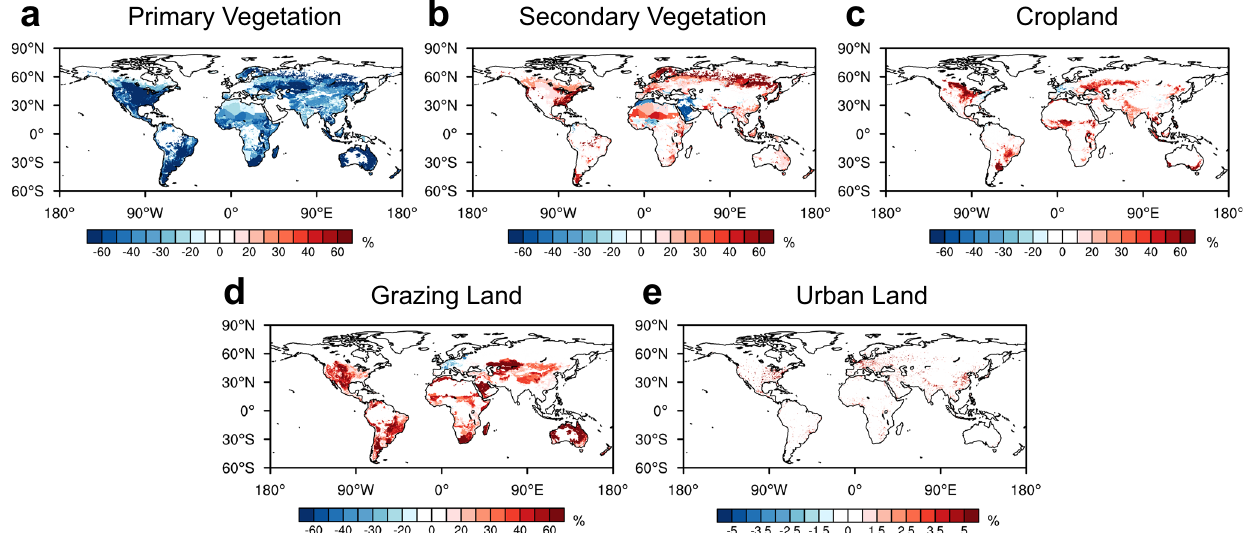
Fig. 2 Spatial patterns of historical land-use and land-cover change (LULCC) from 1850 to 2014 (%, 2014 minus 1850). a Primary vegetation. b Secondary vegetation. c Cropland. d Grazing land. e Urban land. The historical LULCC is based on the LUH2 dataset 4,43,46